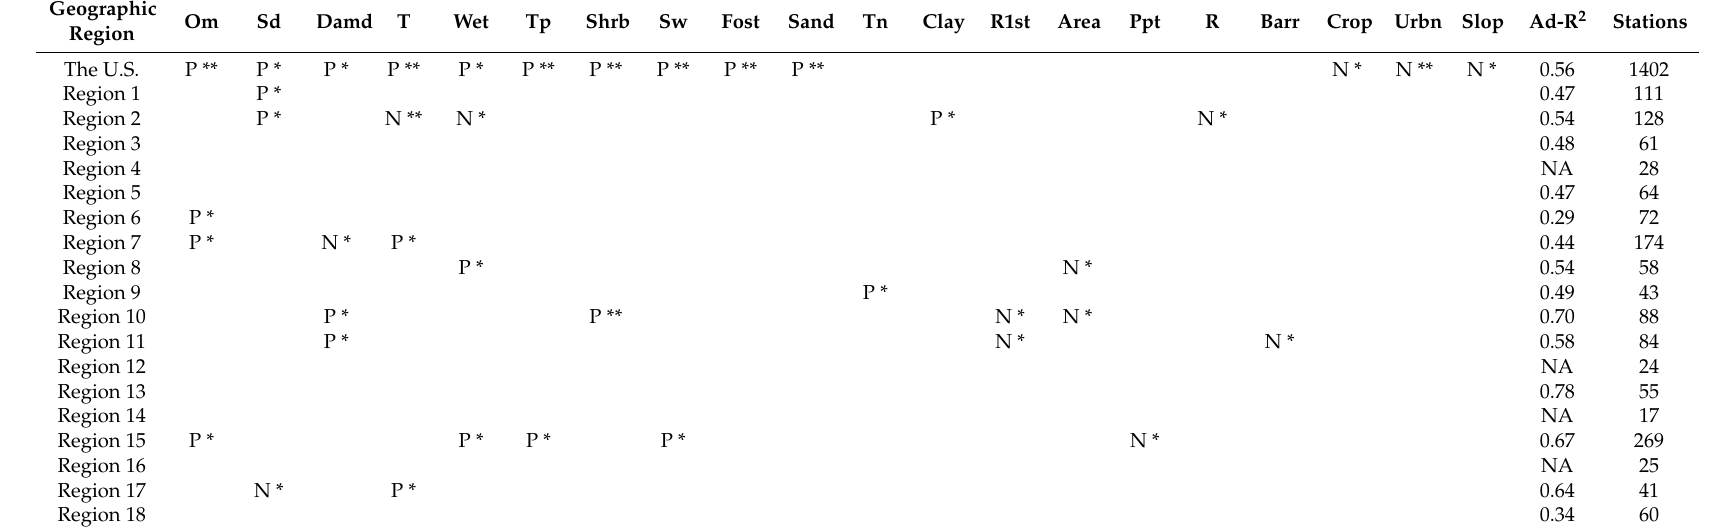
Table 2. General linear regression between environmental factors and DOC concentrations at the national and regional levels. Geographic Om Sd Damd T Wet Tp Shrb Sw Fost Sand Tn Clay R1st Area Ppt R Barr Crop Urbn Slop Ad-R 2 Stations Region The